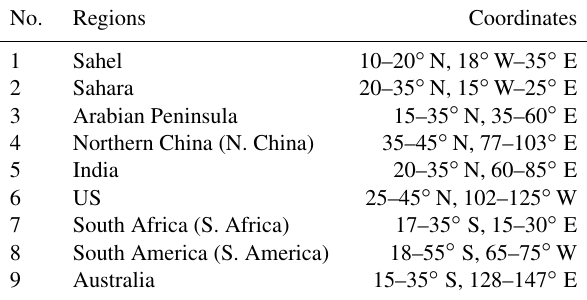
Table 1. Major dust source regions shown in Fig. 1. Note that region names such as India and northern China are not exactly the same as their geographical definitions, as these regions also cover some areas from nearby